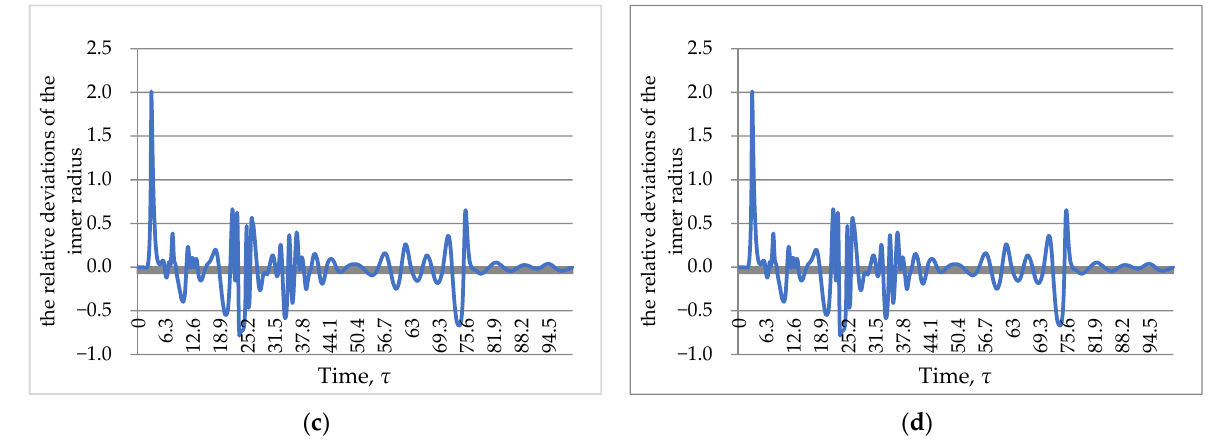
Figure 9. Deviation of the fiber inner radius under various perturbing influences: ( a ) On the inner radius of the preform; ( b ) on the outer radius of the preform; ( c ) on the drawing speed of the finished fiber; ( d ) on the preform feed rate.